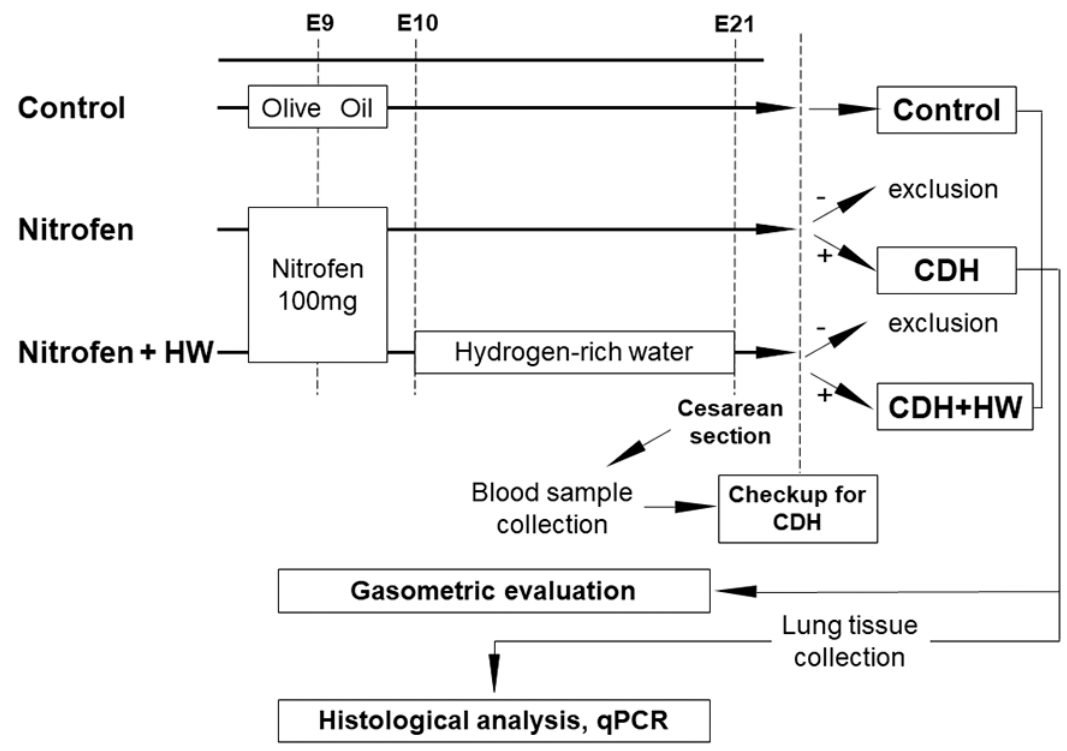
Figure 6. Schema of the design and protocols. Three groups were reconstructed as control, CDH, and CDH + HW. All analyses were compared among these groups. Blood samples were collected before CDH was diagnosed, but the data were only used in these specific groups. CDH, congenital diaphragmatic hernia. HW, hydrogen-rich water.